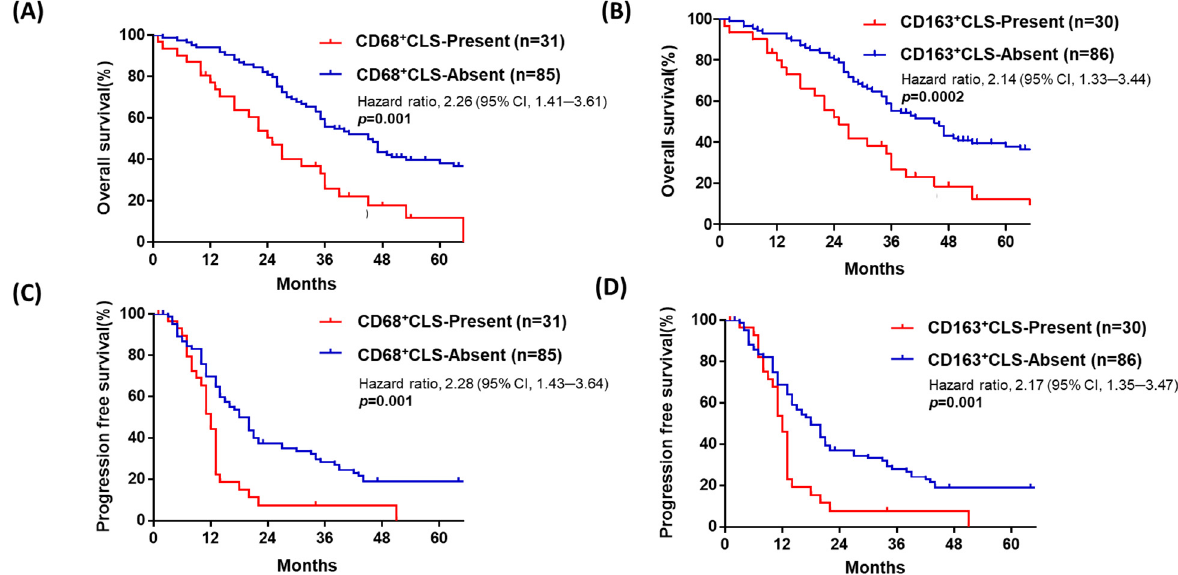
Figure 2. Patients with advanced-stage HGSOC with omental CD68 + or CD163 + CLSs have poorer OS and PFS than those without omental CLSs. In advanced-stage HGSOC ( n = 116), patients with omental CD68 + CLSs (no. ≥ 1) ( A ) or omental CD163 + CLSs (no. ≥ 1) ( B ) had worse OS (median survival: 24 vs. 38 months; 22 vs. 36 months, respectively, p = 0.001; p = 0.002). Patients with omental CD68 + ( C ) or CD163 + ( D ) CLSs had poor PFS (median survival: 11 vs. 15 months; 11 vs. 15 months, respectively p = 0.001, 0.001). Table 2. Univariate and multivariate Cox proportional hazards regression model for overall survival ( n = 116).